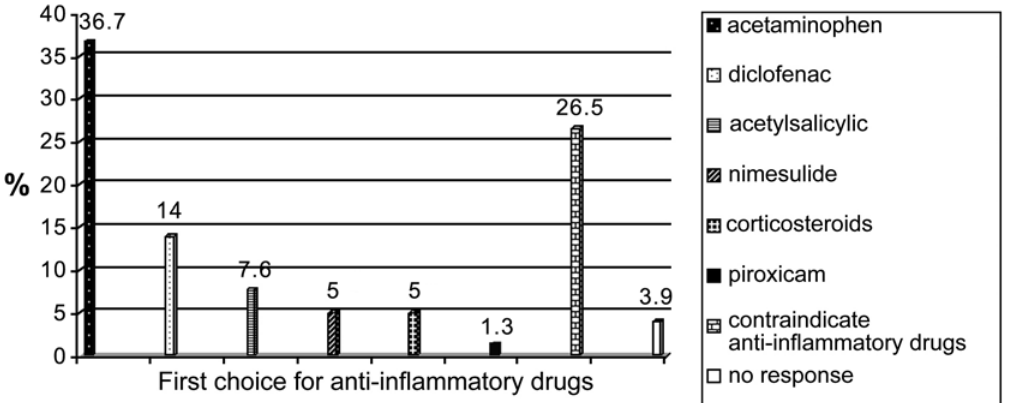
FIGURE 2- Recommendations of obstetricians as to the use of first-choice anti-inflammatory drugs during pregnancy (n=79)